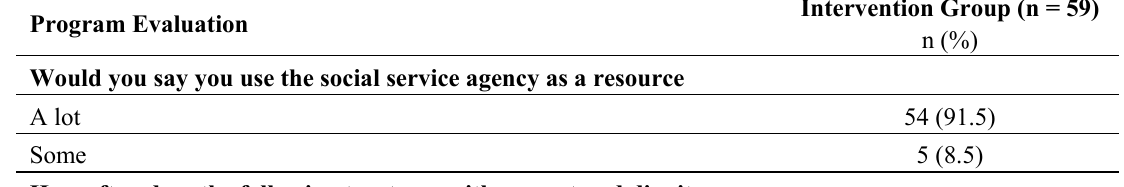
Table 5. Satisfaction with the CHW Program (n =